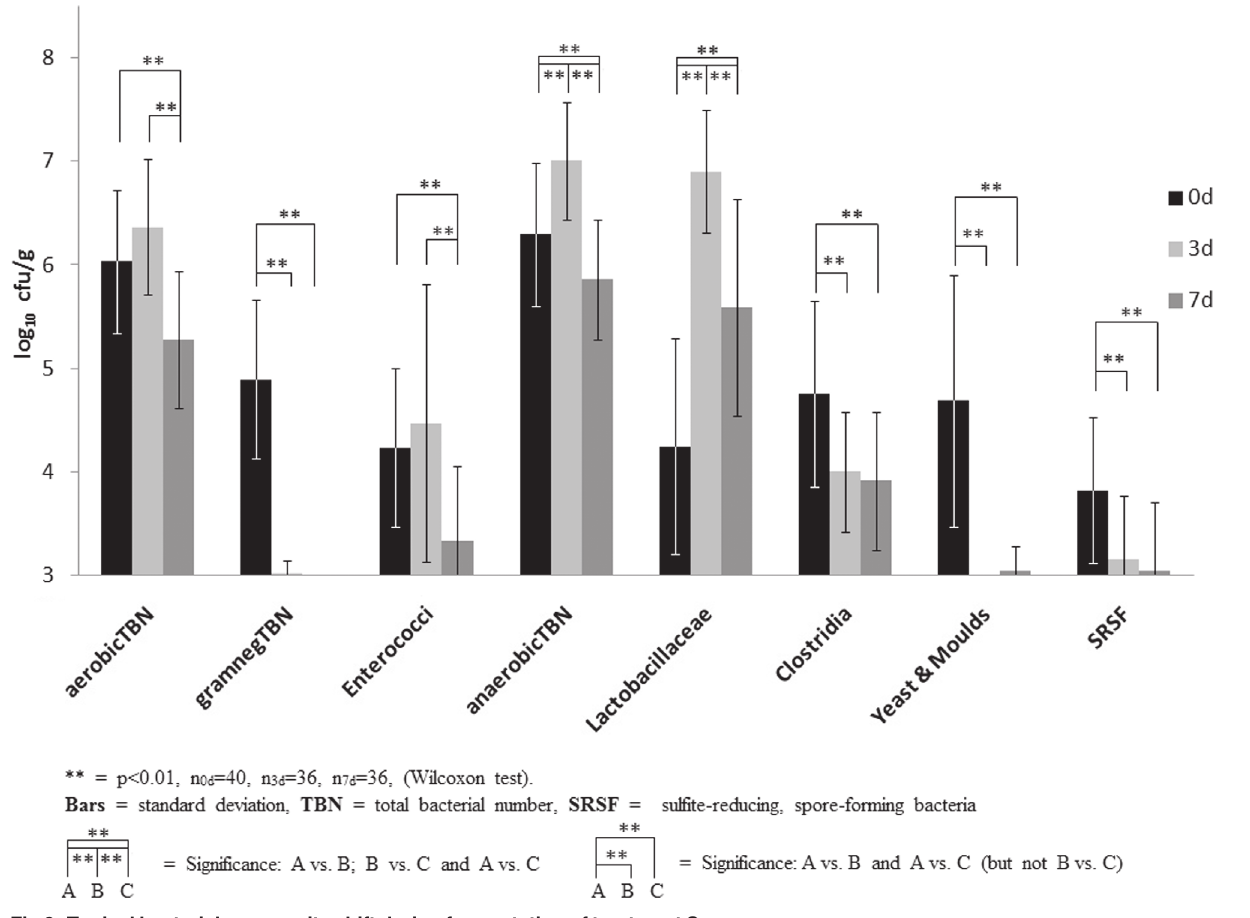
fermentation lock is installed. A small air column is needed because the material swells and may plug the lock. The smell of the treatments changed from a typical faecal smell to a sour, silage-like odour with fermentation. Gram-negative bacteria, enterococci or yeasts and moulds could not be found in treatments S and Fe+WB, but were present in treatments without the wheat bran -WB and S -WB+SD, Table 4). (S Pool Pool